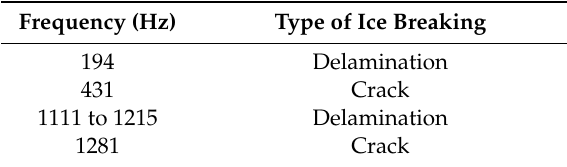
Table 2. Frequencies and type of ice breaking obtained with camera